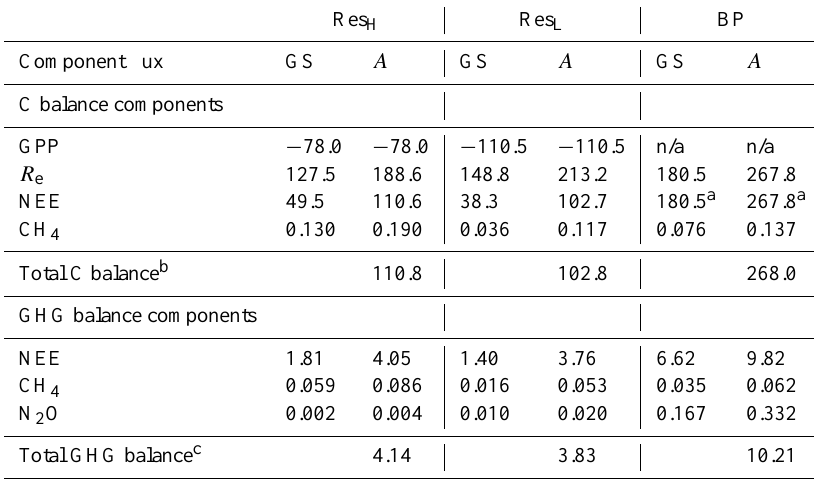
Table 6. Growing season (GS; 1 May to 31 October) and annual ( A ) sums of the carbon balance components (gCm − 2 ) including gross primary production (GPP), ecosystem respiration ( R e ), net ecosystem exchange (NEE) of CO 2 and methane (CH 4 ) fluxes, as well as the greenhouse gas (GHG) balance components (tCO 2 eqha − 1 ) including NEE, CH 4 and nitrous oxide (N 2 O) exchanges (using global warming potentials of 34 and 298 for CH 4 and N 2 O, respectively) in restoration treatments with high (Res H ) and low (Res L ) water table level and bare peat (BP); negative and positive fluxes represent uptake and emission, respectively. Res H BP